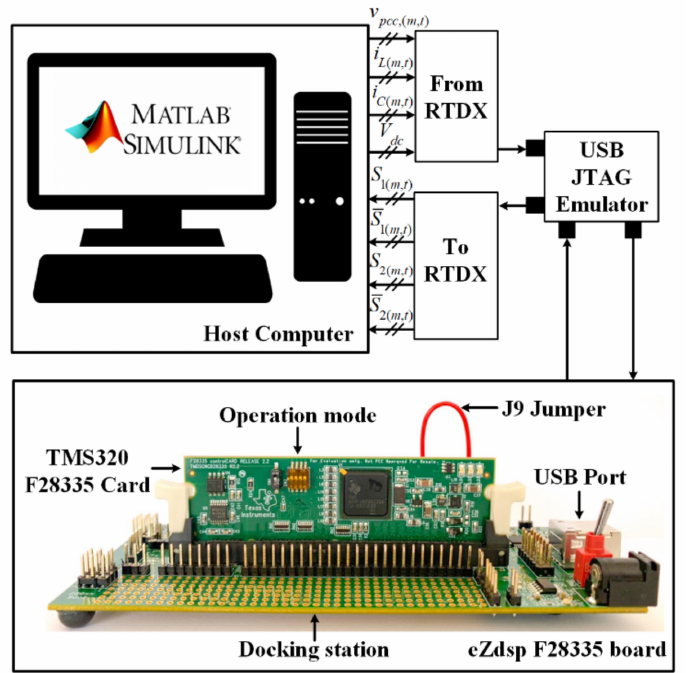
Figure 6. The configuration of the hardware-in-the-loop (HIL) simulation. The HIL simulation model used to test the performance of the harmonic mitigation is shown in Figure 7. The PCC voltages ( v ), load currents ( i ), compensating pcc , ( m , t ) L ( m , t ) currents ( i ), and DC bus voltage ( V dc ) were measured from the considered power C ( m , t ) systems. These data were sent to the target of eZdsp F28335 with the “From RTDX” block, and were calculated in the overall control strategy to generated the pulses ( S m , t ). S m , t were transferred into the host computer via the “To RTDX” block. S m , t were used to switch the IGBTs of the APF for the compensating current injection